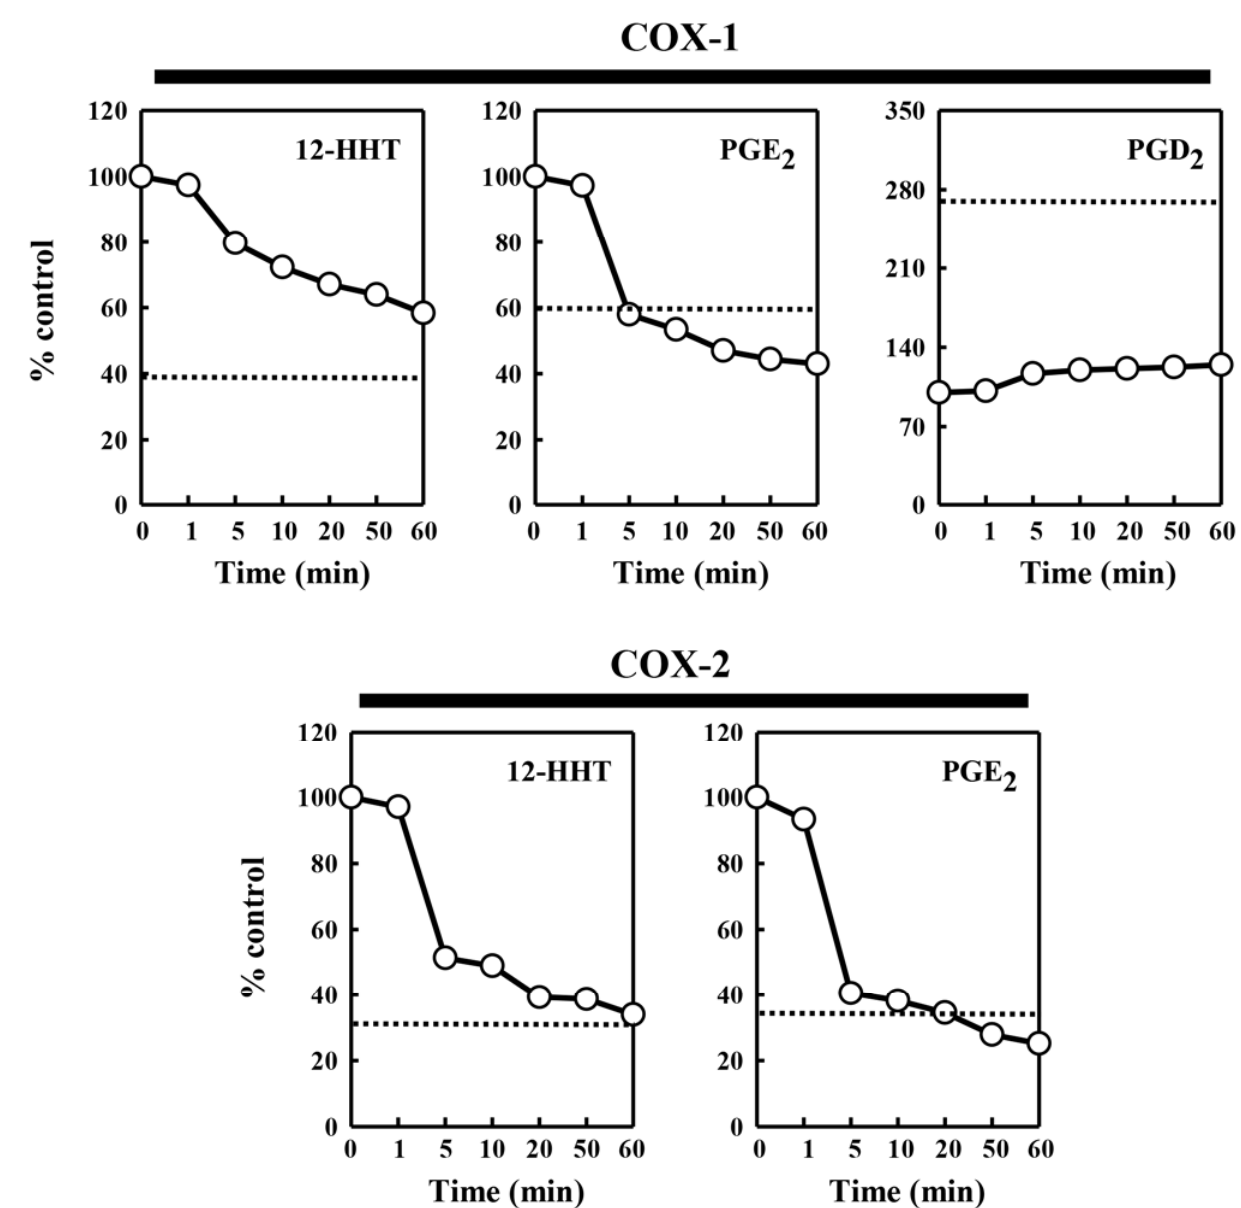
Figure 4. Effect of chymotrypsin pretreatment of the pig kidney microsomes on their ability to modulate the COX-1 and COX-2 catalytic activity. The incubation mixture consisted of 30 μ g protein/mL of the pig kidney microsomes (pretreated with chymotrypsin), 20 μ M [ 14 C]AA (0.2 μ Ci) as a substrate, 0.5 μ g/mL COX-1 and 0.97 μ g/mL COX-2 as the enzyme in 10 mM EDTA, 1 mM reduced glutathione, and 1 μ M hematin in 200 μ L of 100 mM Tris-HCl buffer, pH 7.4. For the formation of PGE 2 catalyzed by COX-1, the pig kidney microsomes (at 60 μ g protein/mL, pretreated with chymotrypsin) were added. The incubations were carried out at 37 °C for 5 min. Chemotrypsin pretreatment of the pig kidney microsomes lasted 0, 0.5, 5, 10, 20, 40, and 60 min. Each value is the mean of duplicate measurements, with small replicate variations (usually well below 10%). The dotted line shows the relative level of the COX-2 catalytic activity in the absence of the pig kidney microsomes.